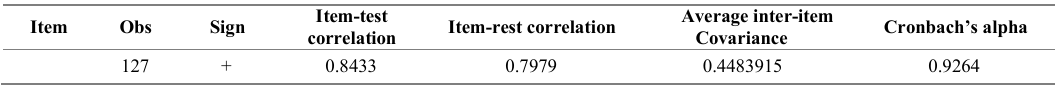
Table 3. Cronbach’s alpha